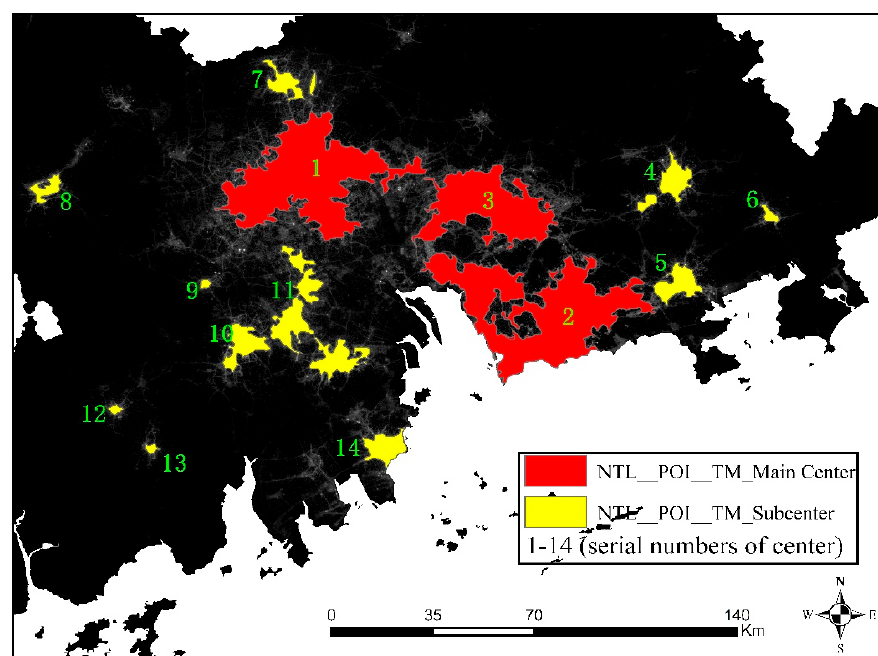
Figure 12. The main centers and subcenters identified by